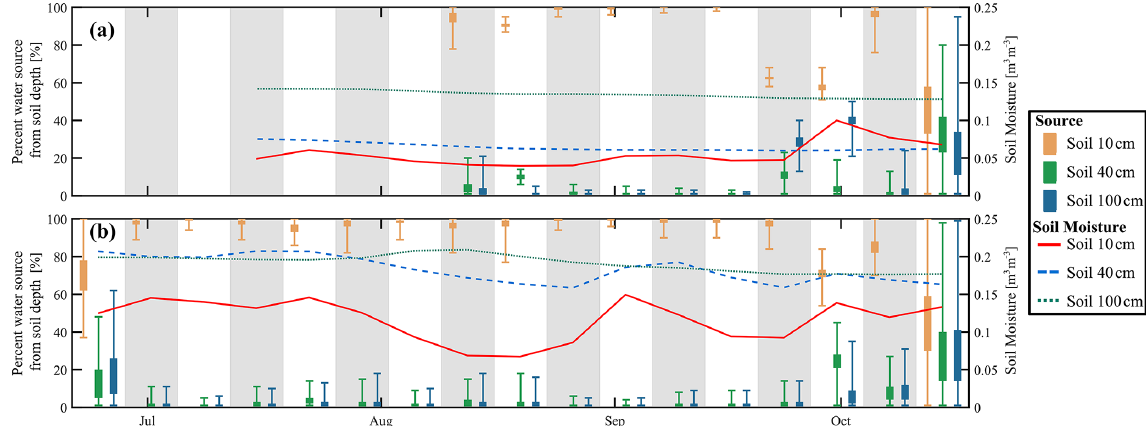
Figure 9. Estimated percentage of willow water from each soil depth in (a) Northern Willow and (b) Southern Willow. The box plots for each source show the 25th and 75th percentiles, with whiskers extending to the minimum and maximum estimated proportion. Grey and white bands show the division of each week. The right-hand y axis shows the soil moisture for each soil depth (weekly